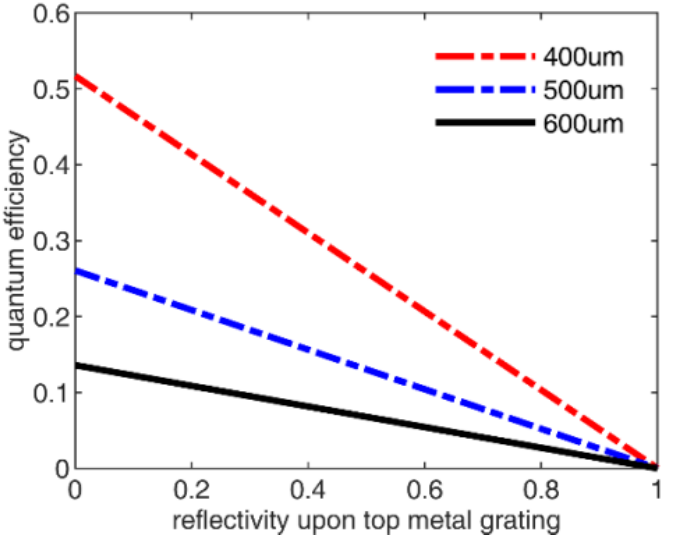
Figure 11. Quantum efficiency under the different reflectivity upon top metal grating.